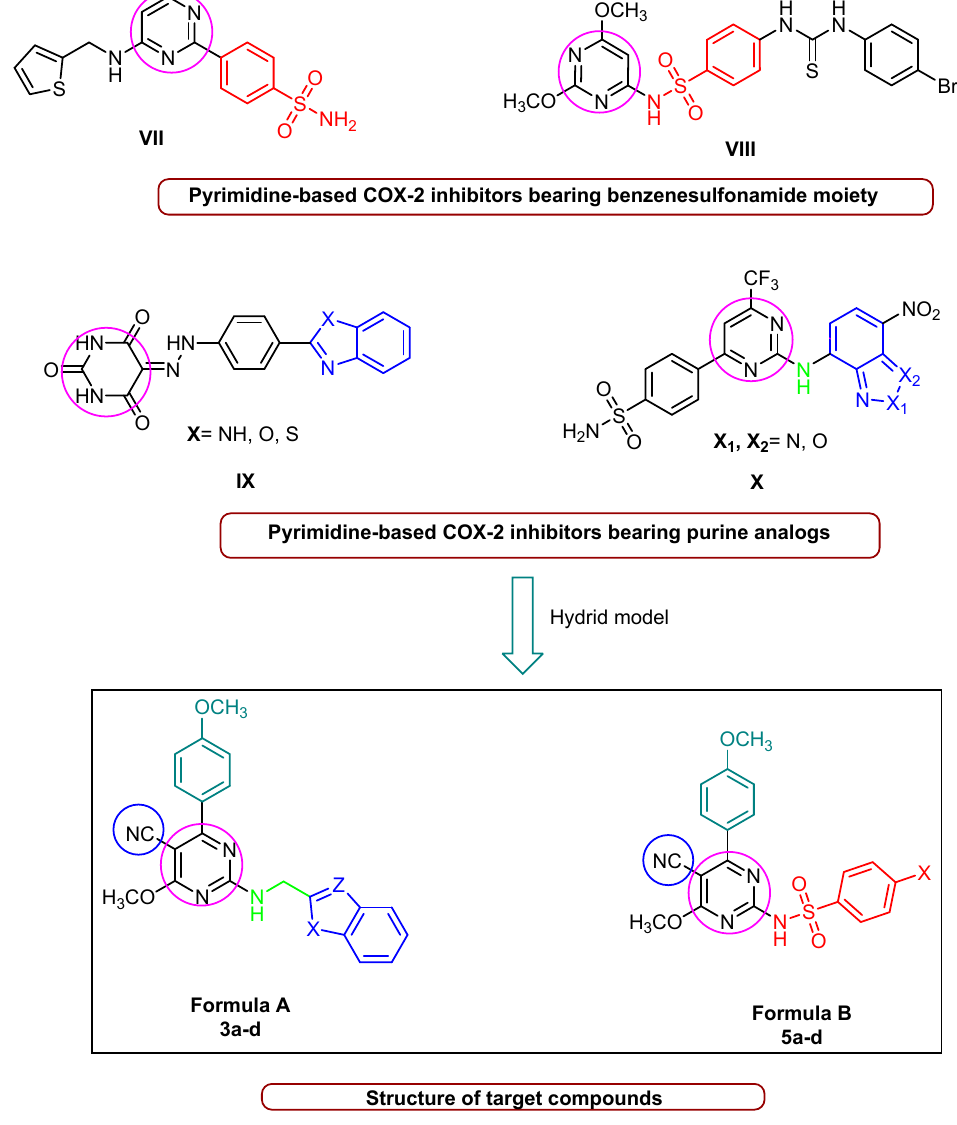
Figure 2. Pyrimidine-based COX-2 inhibitors and rationale for designing the target compounds.